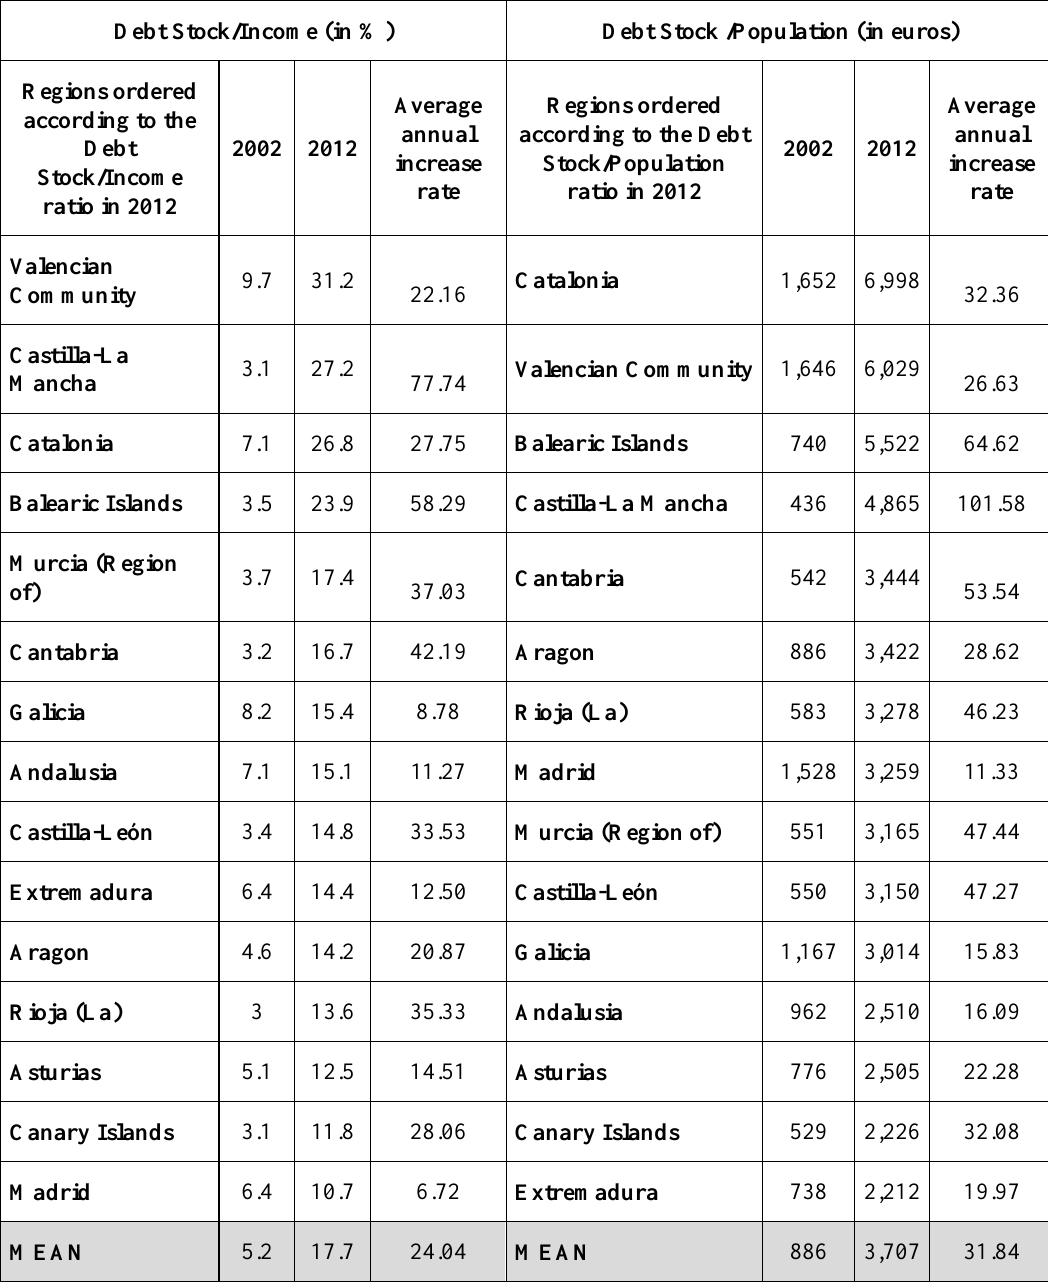
Table 6 : Changes in the credit situation of the Autonomous Regions (2002–2012) Debt Stock/Income (in %) Debt Stock /Population (in euros) Regions ordered Regions ordered according to the rate